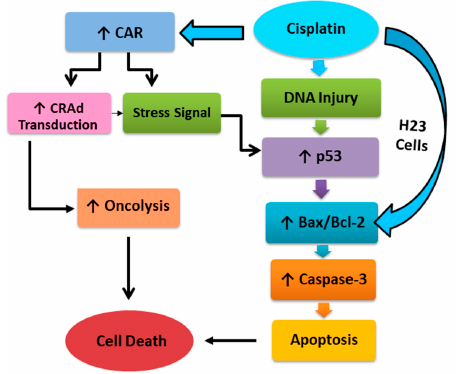
Figure 8. Molecular mechanism underlying cisplatin and CRAd induced cancer cell death.